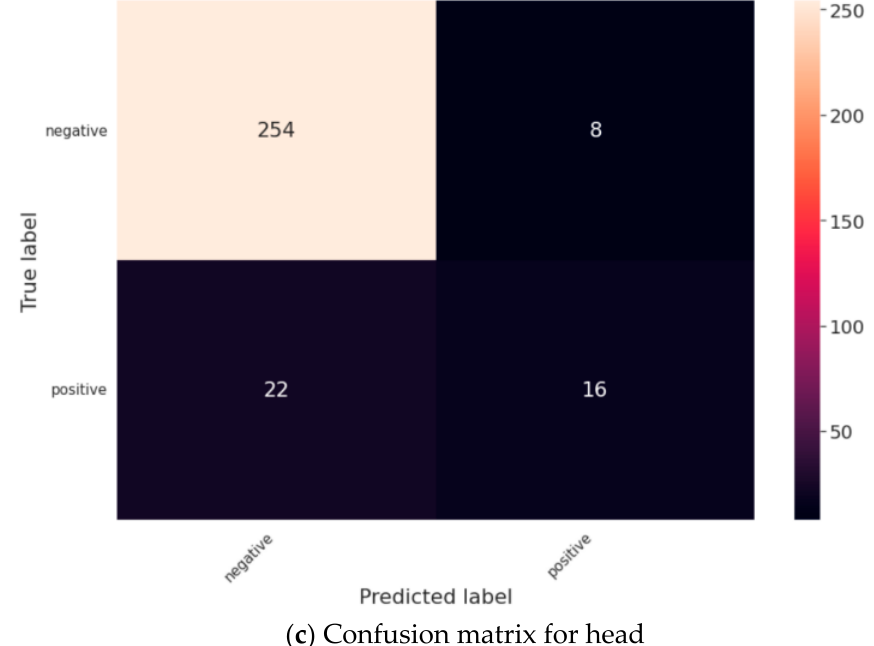
Figure 4. Confusion matrix for different labels of given dataset.